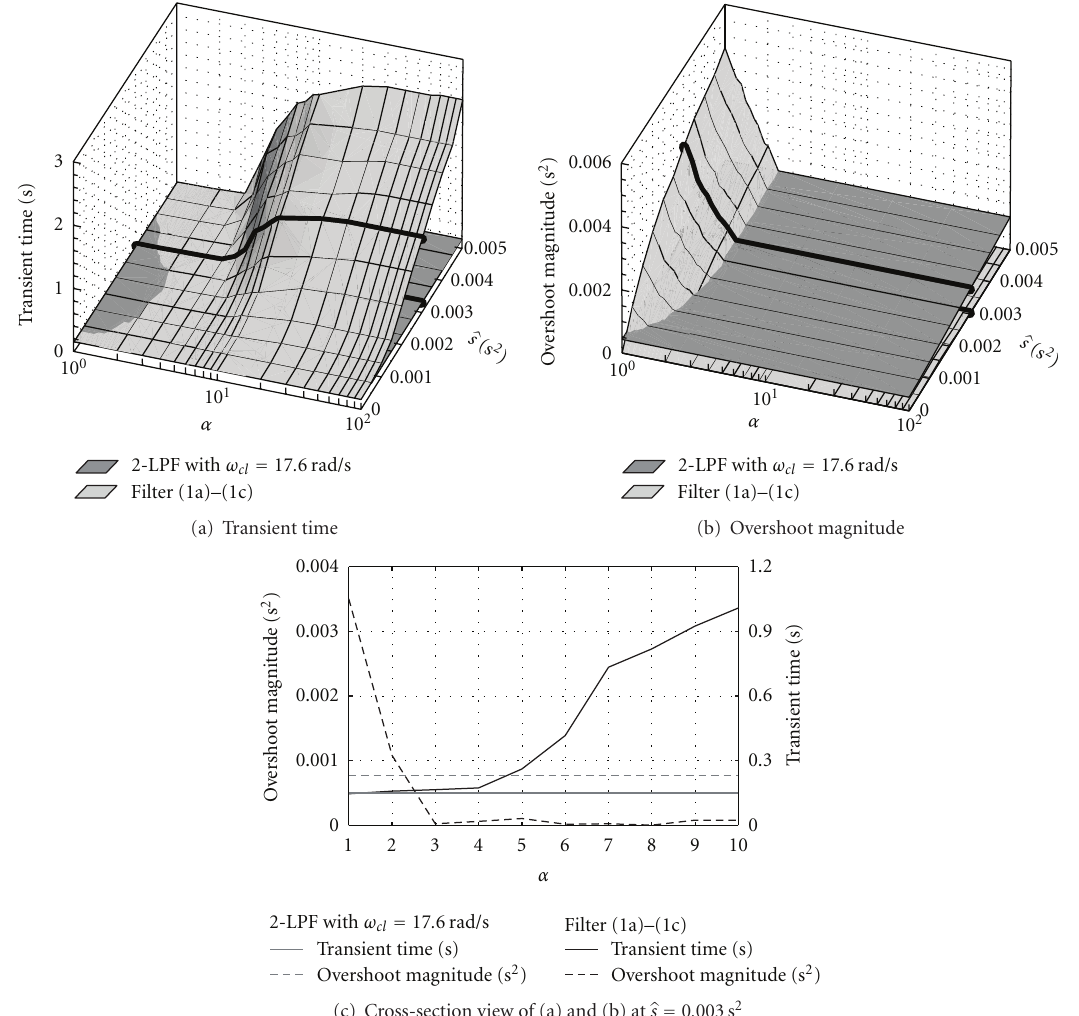
Figure 8: Transient time and overshoot magnitude with normalized input (cid:8) u ( t ) = 0 . 01 + (cid:8) sε ( t )s 2 , which is a step input corrupted by white Gaussian noise. In each figure, the result of filter (1a)–(1c) with α = 1 refers to that of filter